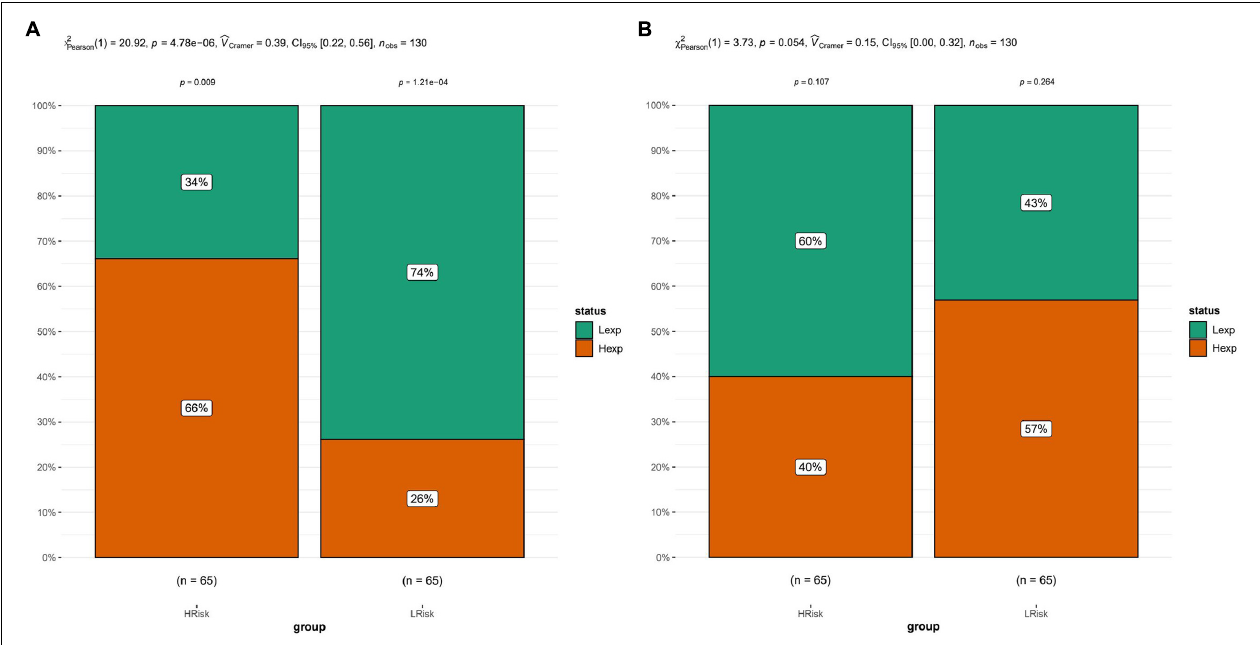
FIGURE 5 | Tide analysis. (A) Analysis of immune dysfunction. (B) Immune function rejection analysis. The results showed that there were significant differences in immune dysfunction between the high-risk and low-risk